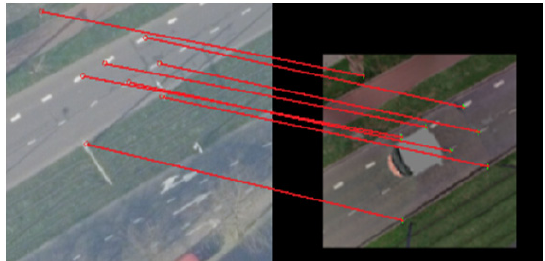
Figure 15 Förstner/SURF matching result of 12 th tile